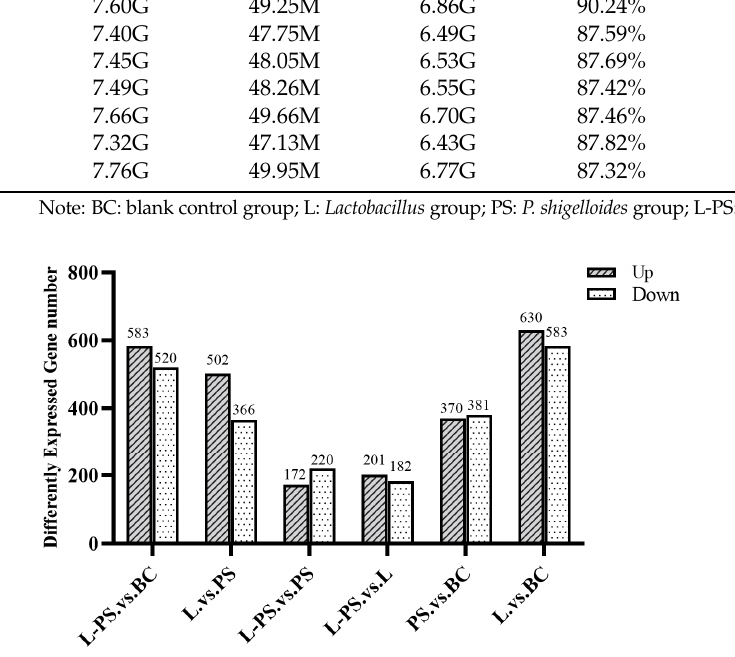
Figure 2. DEG statistics for all groups.